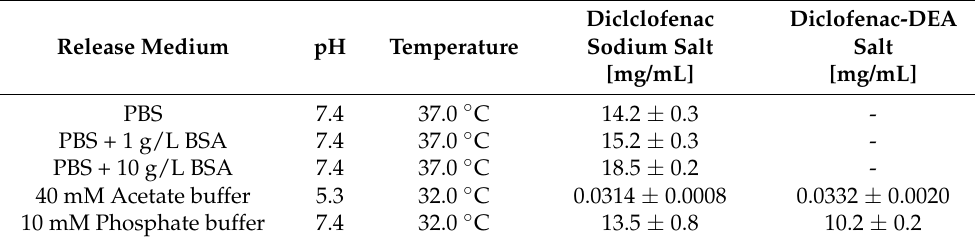
Diclofenac-DEA Diclclofenac Salt Sodium Salt [mg/mL] [mg/mL]